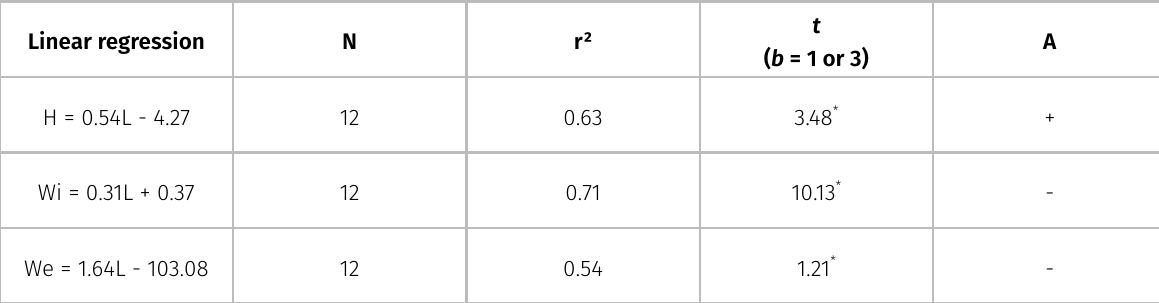
Table I. Relationships between shell length (L) and morphometric variables of Anodontites trapesialis living specimens. Linear